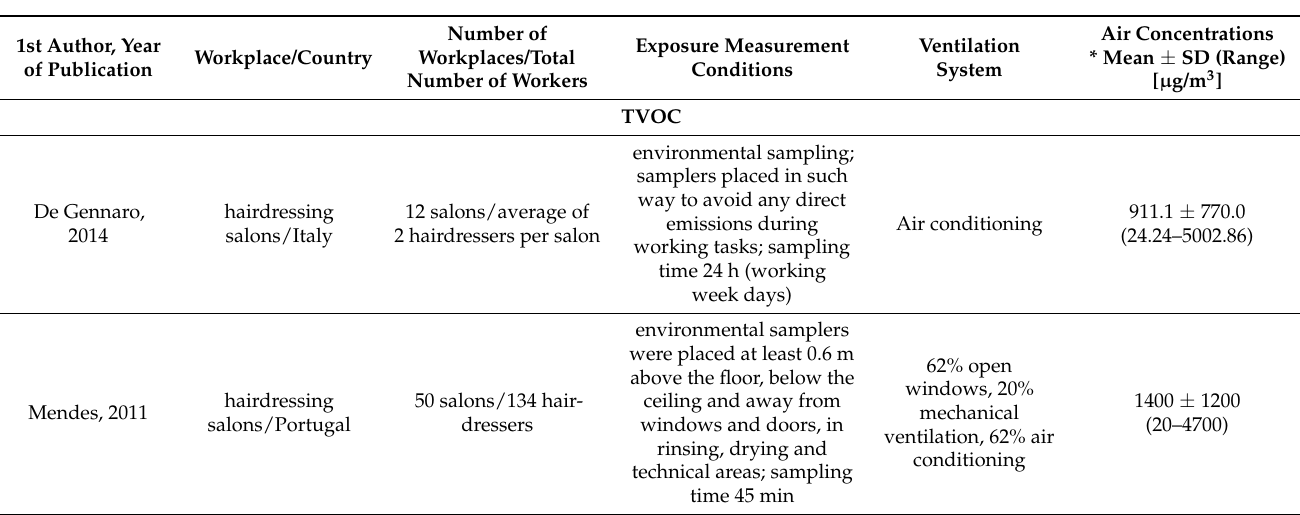
Table 3. Summary of studies reporting air concentrations of organic solvents: total volatile organic compounds (TVOC) ( n = 5), toluene ( n = 4), xylene (isomers) ( n = 5), acetone ( n = 3), benzene ( n =